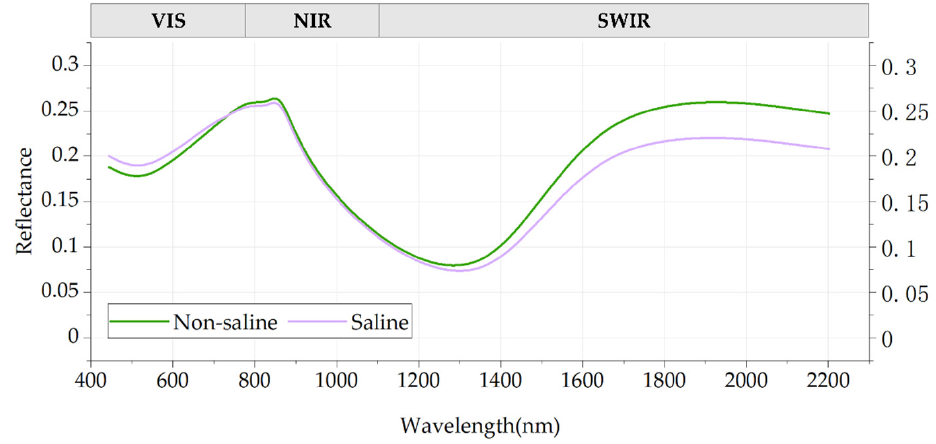
Figure 7. Reflectance curve of non-saline and saline cropland samples over the wavelength range of Sentinel-2 data in dry season.